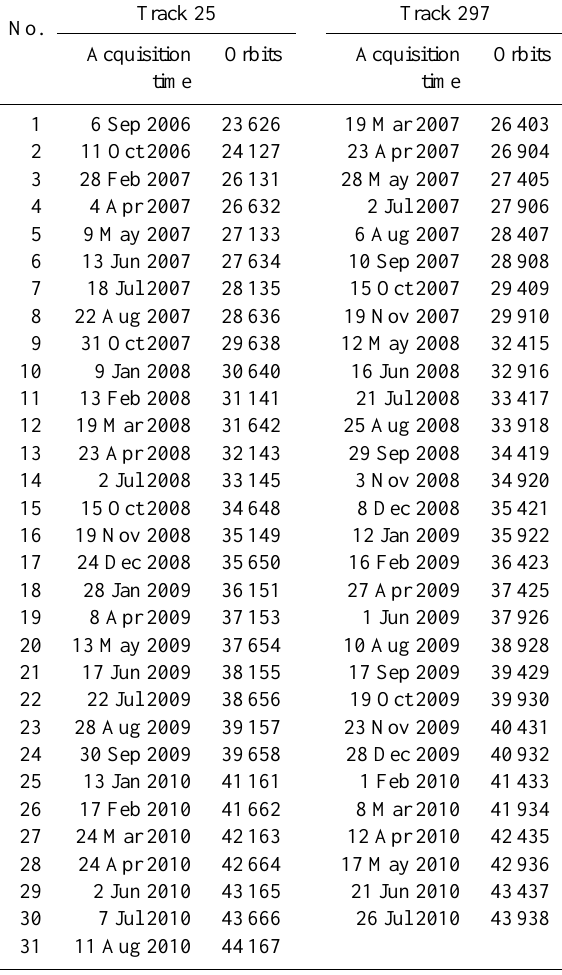
Table 1. The Envisat ASAR data used in this study. No.